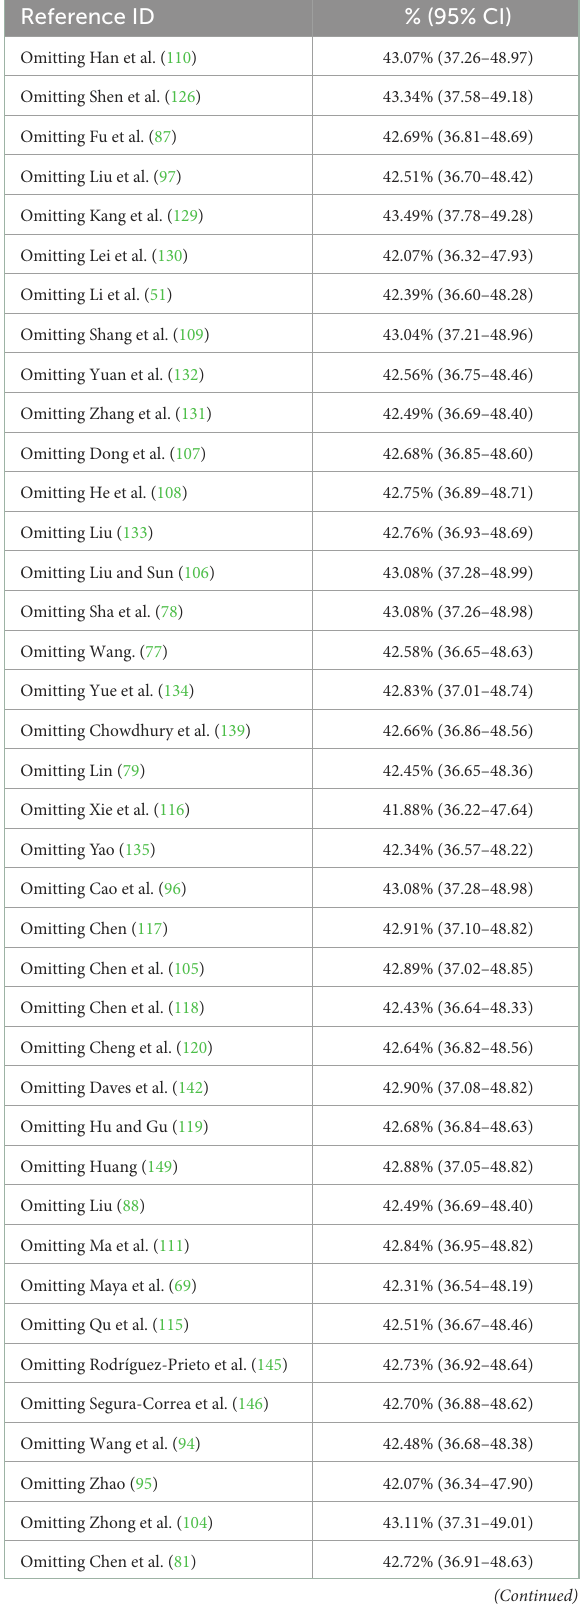
TABLE 8 Sensitivity analysis (decetion